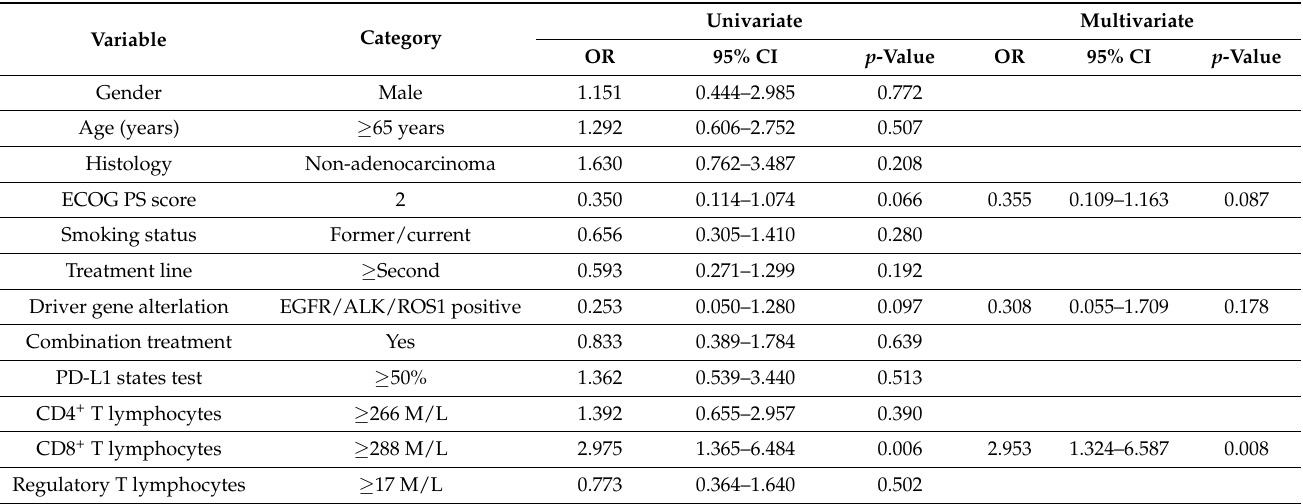
Table 3. Univariate and multivariate analyses for the risk factors of immune-related adverse events